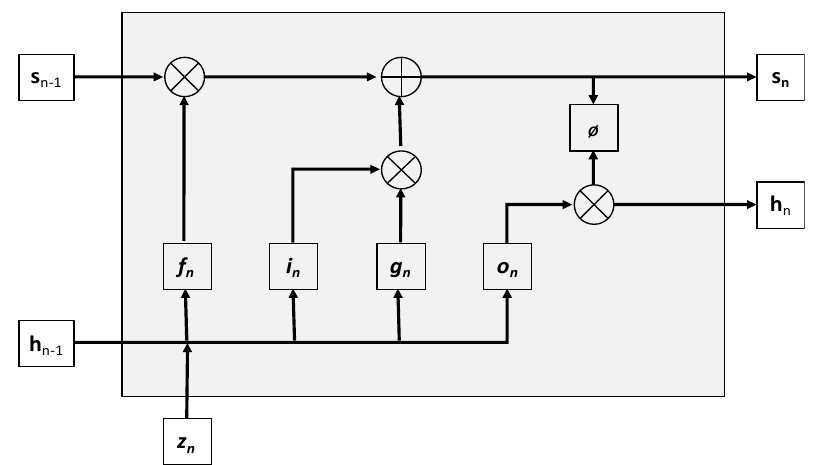
Figure 2. An LSTM − RNN cell with gated units.